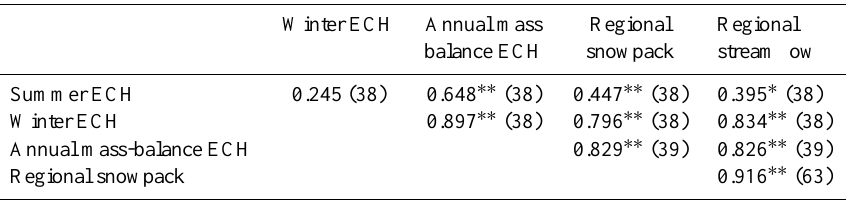
Table 2. Correlation analyses between the ECH mass-balance series and regional hydroclimatic records. The number of observations used in each correlation test is indicated in parenthesis.